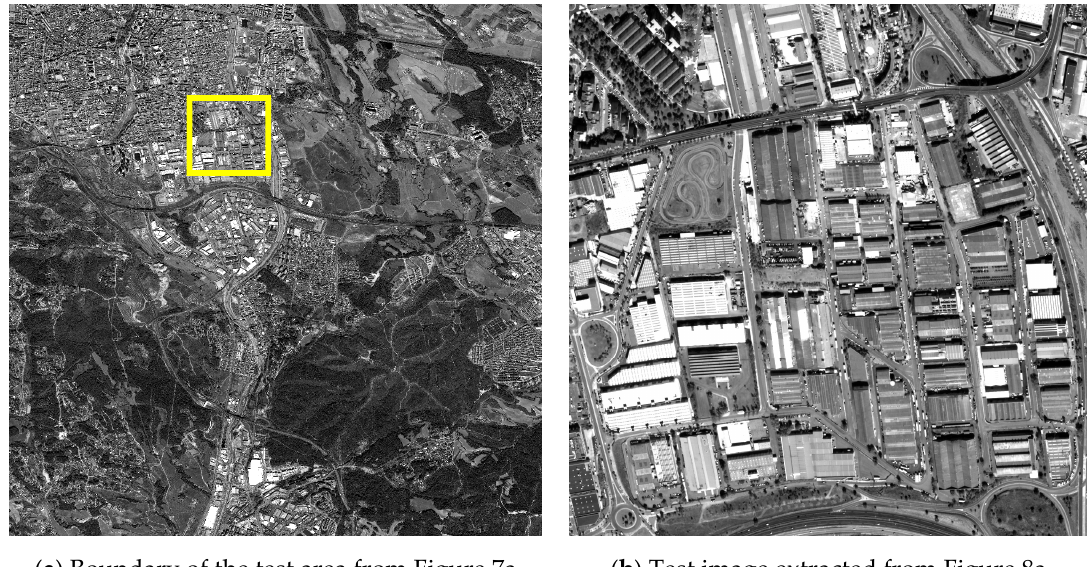
Figure 8. Stereo Worldview-1 images.